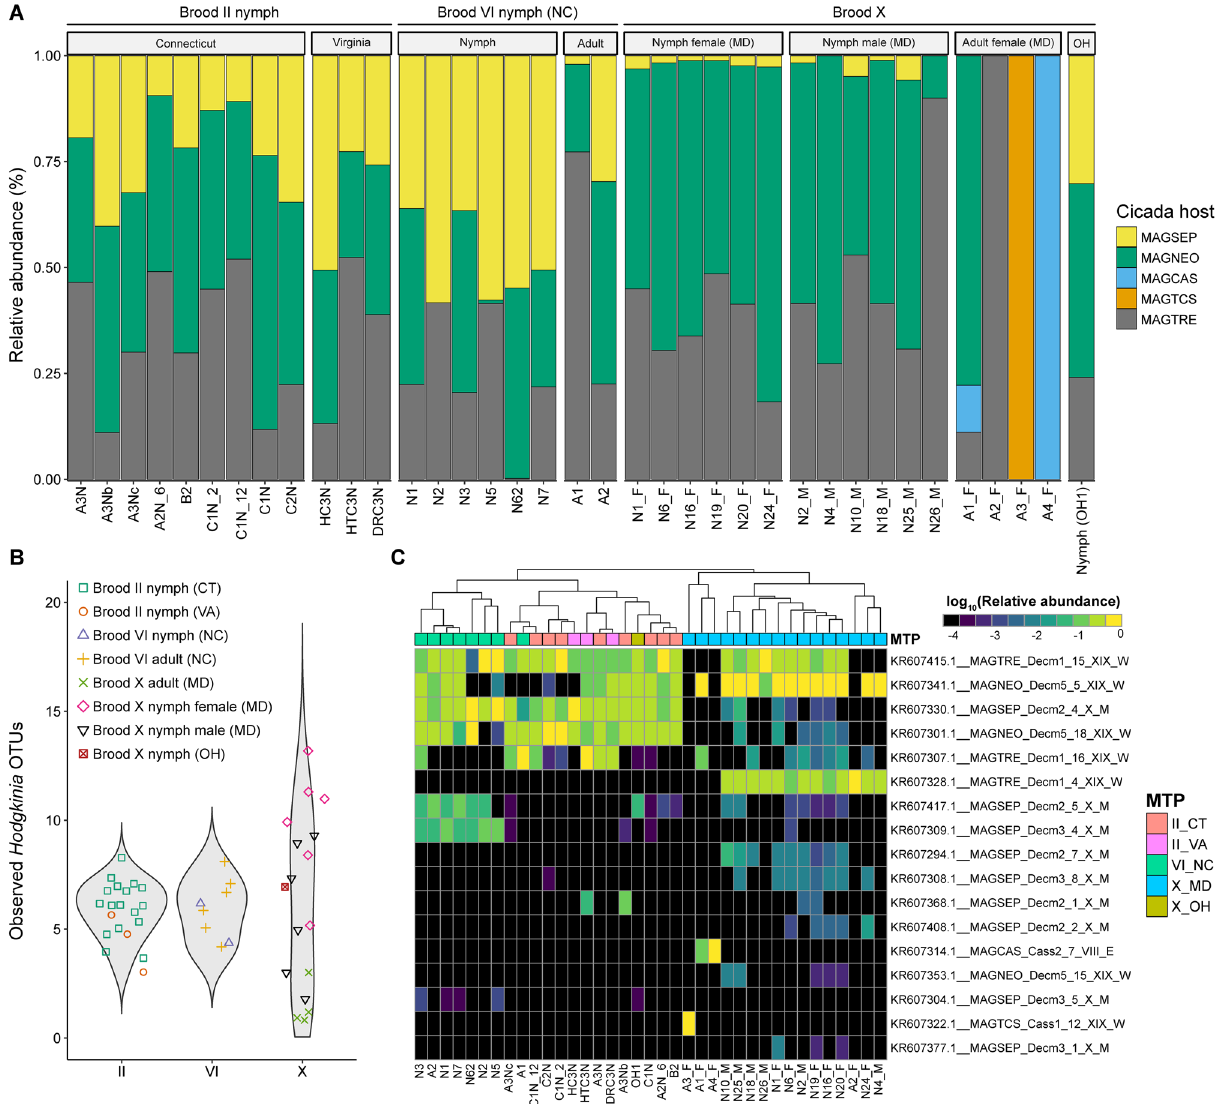
Figure 7. Detection and identification of Hodgkinia OTUs. ( A ) Stacked bar plot showing relative abundance of Hodgkinia OTUs classified by cicada host species. Characterization of Hodgkinina and proposed nomenclature is described elsewhere 33 . MAGNEO, Magicicada neotredecim ; MAGTRE, Magicicada tredecim ; MAGCAS, Magicicada cassini ; MAGTCS, Magicicada tredecassini ; MAGSEP, Magicicada septendecim . ( B ) Violin plot showing number of observed Hodgkinia OTUs between brood and MTP set. ( C ) Heatmap showing Log 10 (relative abundance) of Hodgkinia OTUs. Dendrogram shows k-means clustering of